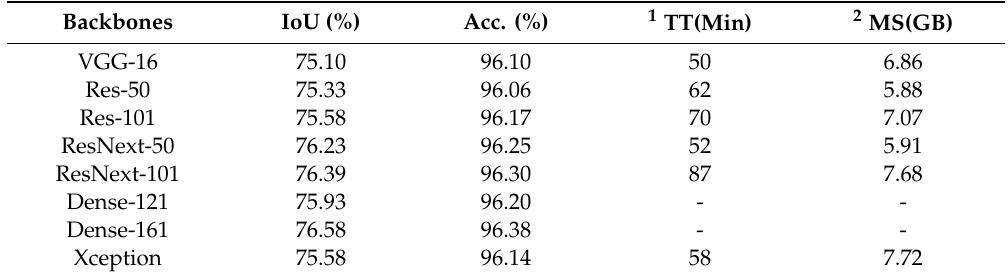
Table 1. The Intersection over Union (IoU) and Acc.. of various backbone encoders for the validation set.